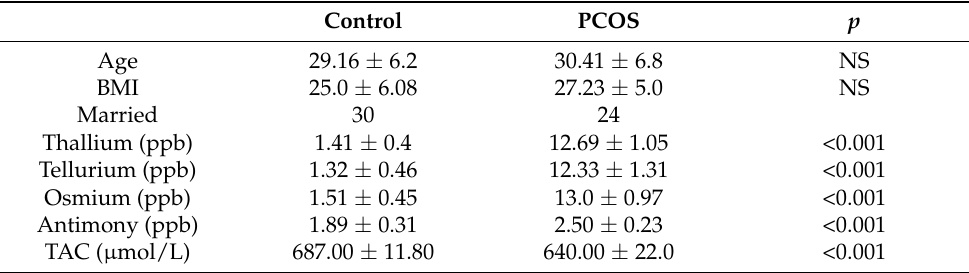
Table 1. Baseline characteristics and serum levels of heavy metals and TAC in controls and PCOS patients.